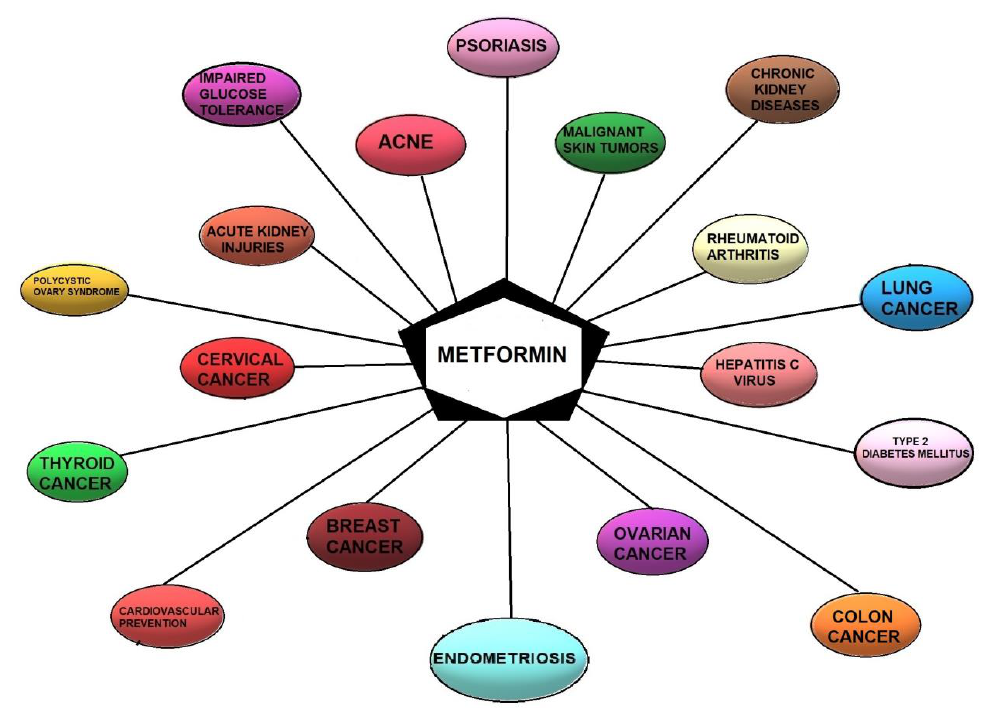
Figure 2. Current and potential therapeutic indications for metformin.